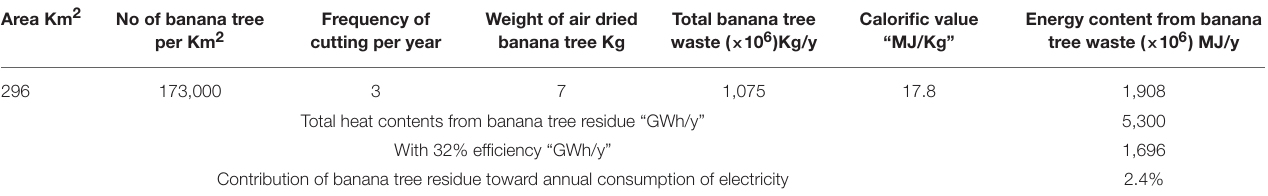
TABLE 5 | Energy production from banana crop per year (Saeed et al., 2015). Area Km 2